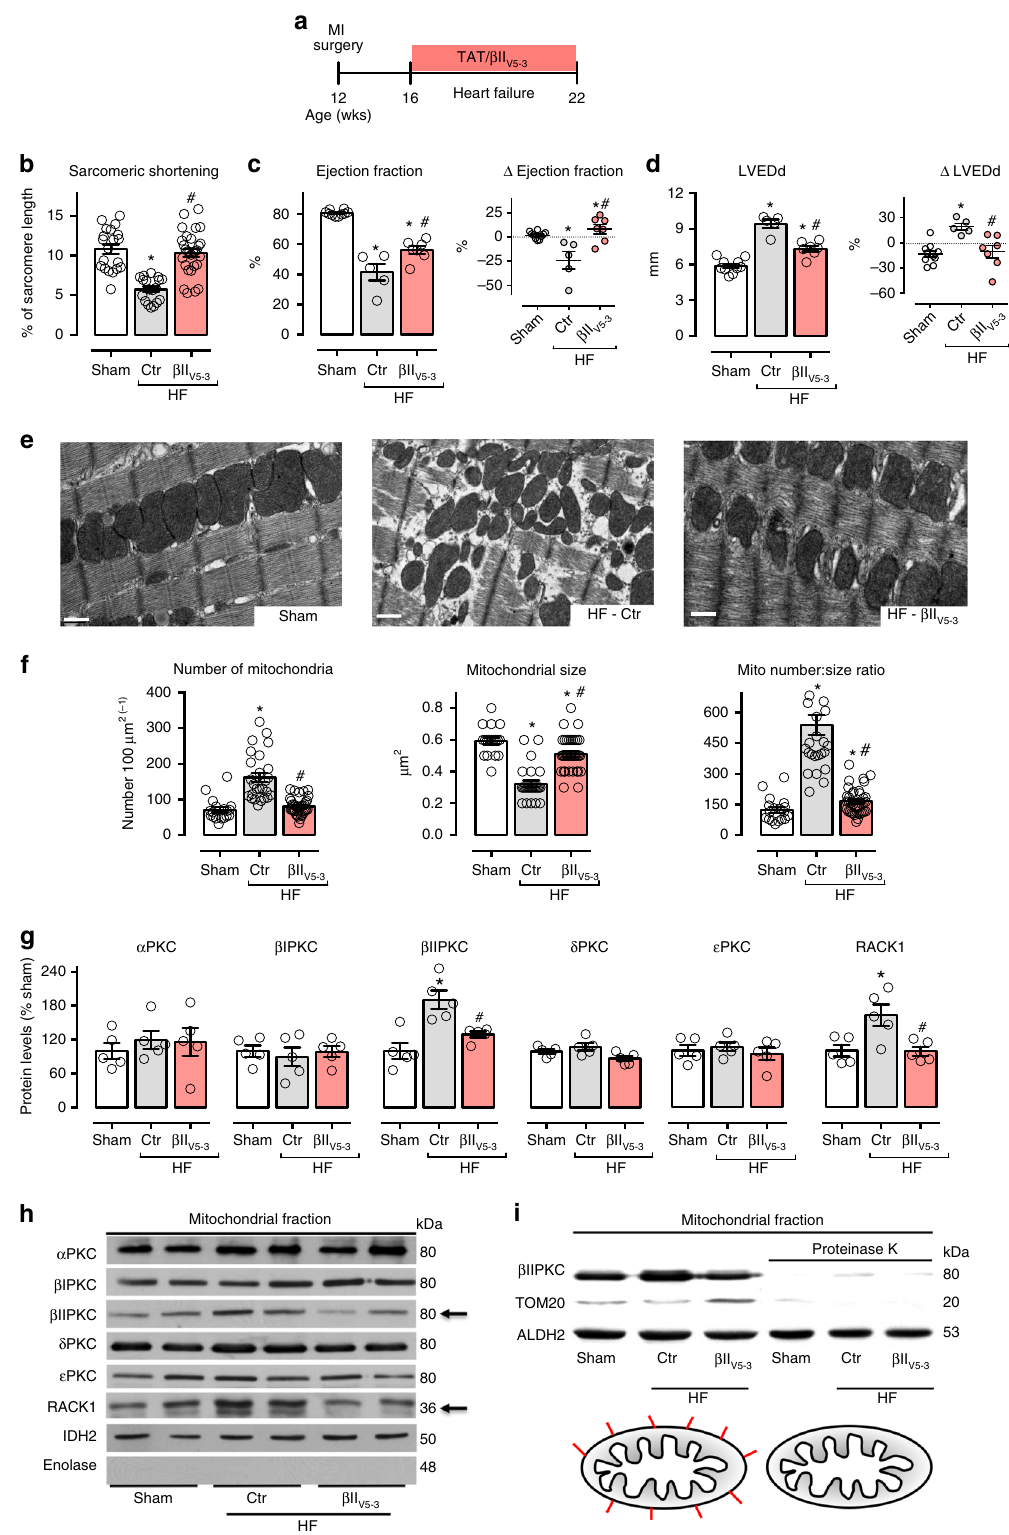
treatment with β II V5-3 also protected adult cardiomyocytes from oxidative stress (a known trigger of mitochondrial fragmenta- tion 22 ) (Fig. 2g, h), similar to what we found in neonatal cardiomyocytes. These fi ndings demonstrate that suppressing β IIPKC is suf fi cient to protect both neonatal and adult cardiac